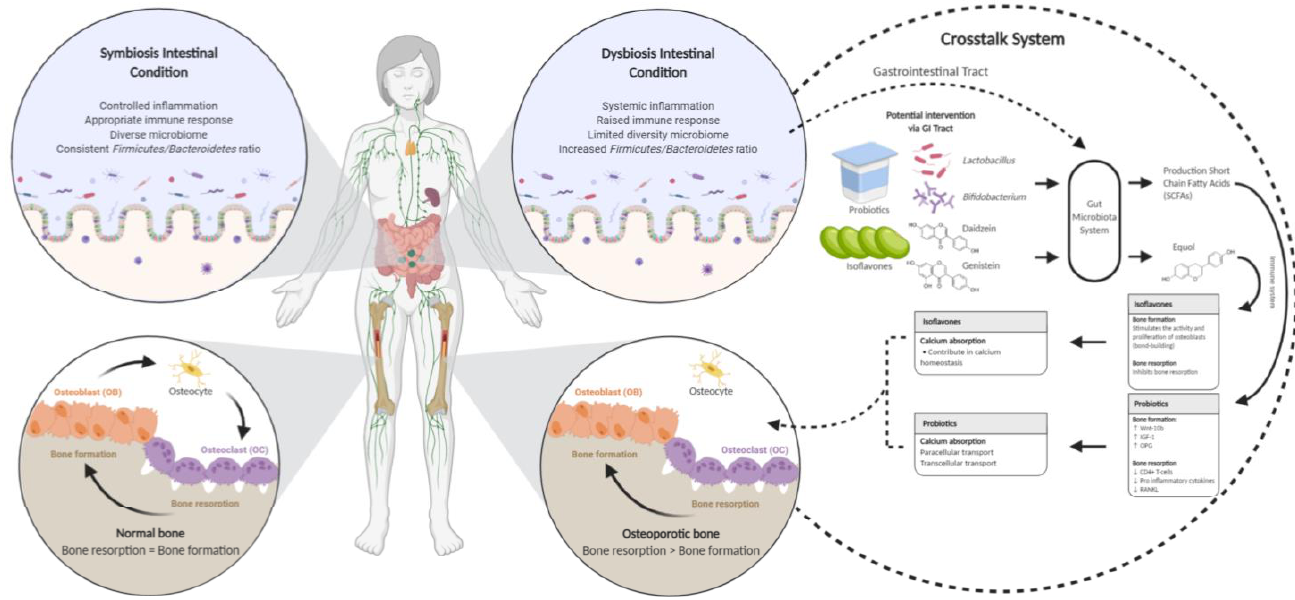
Figure 2. The crosstalk system mechanism of probiotics and isoflavones that benefits bone. An unhealthy balance in the microbiota community composition is linked to various metabolic, inflammatory, and immunologic diseases [32], and vice versa. The imbalance of the gut microbiome can cause the imbalance of osteogenesis and osteoclast reaction [33]. The gastrointestinal (GI) tract system contributes to absorbing bone mineralization [40]. The mechanism of action between probiotics and isoflavones regulates the GI tract system and calcium homeostasis. In the GI tract system, probiotics increase short-chain fatty acids [65] and elevate the immune system [55] to regulate the function of bone formation by increasing the level of Wnt Family Member 10B (Wnt10b), insulin-like growth factor 1 (IGF-1), and osteoprotegerin (OPG) [15] and lead the function of bone resorption by decreasing the level of CD4+ T cells, pro-inflammatory cytokines, and receptor activator of nuclear factor- κ B ligand (RANKL) [15,54,55]. Furthermore, gut microbiota converts isoflavones (daidzein and genistein) to equol in the GI tract [63]. Isoflavones stimulate the activity and proliferation of osteoblasts [47] and inhibit bone resorption [26]. Isoflavones prevent bone resorption [58,59]. Isoflavones contribute to calcium homeostasis [70], and probiotic modulates the transcellular and paracellular pathways [46]. ↑ : increase; ↓ :